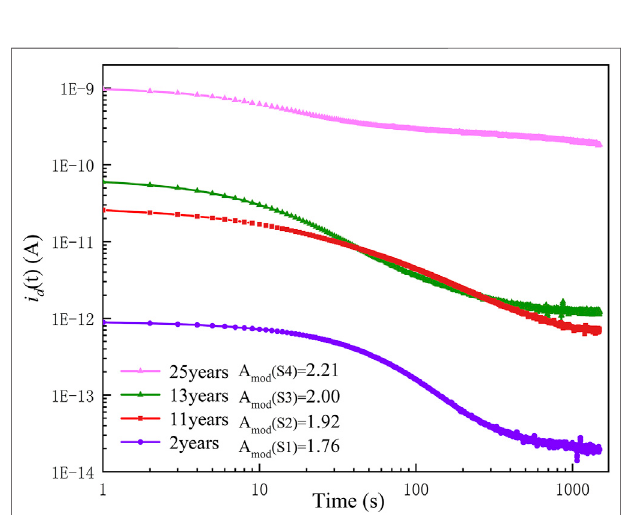
FIGURE 7 | PDC curve and Amod of XLPE cables with different service life.